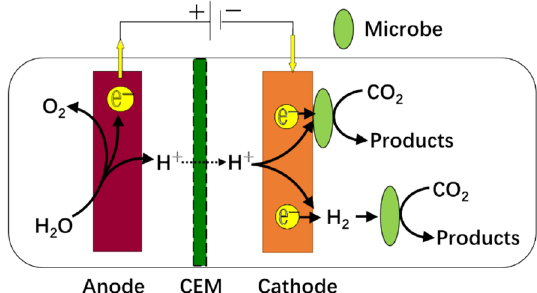
Fig. 1 The schematic of MES reactors (CEM: cation exchange